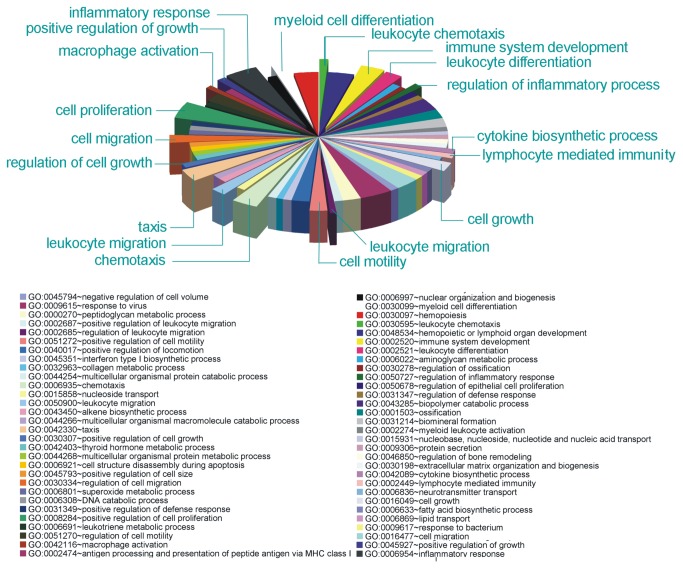
Gene Ontology enrichment analysis showing gene categories whose expression is modulated by MWCNTs.See Table S2 for statistics.